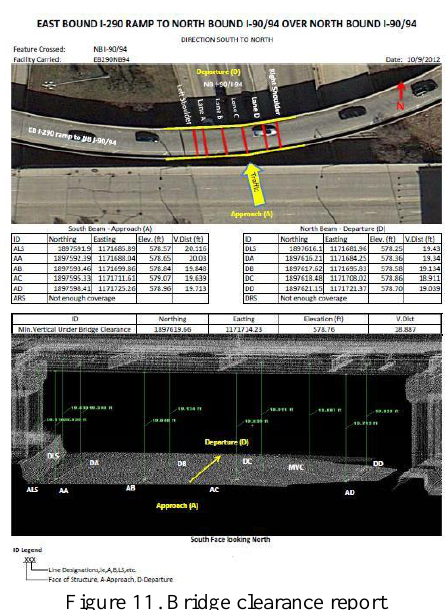
Figure 11. Bridge clearance report